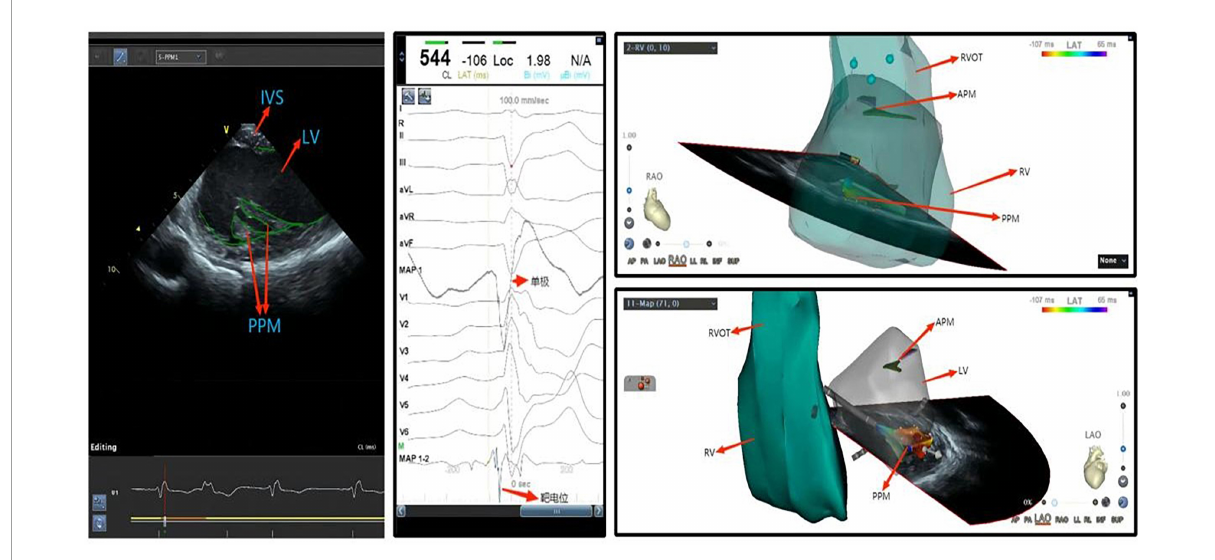
FIGURE5 Ventricular premature beat of left ventricular posterior papillary muscle. IVS, interventricular septum; LV, left ventricle; APM, anterior papillary muscle; PVOT, right ventricular outflow tract; PPM, posterior papillary muscle; RV, right ventricle; LV, left ventricle.